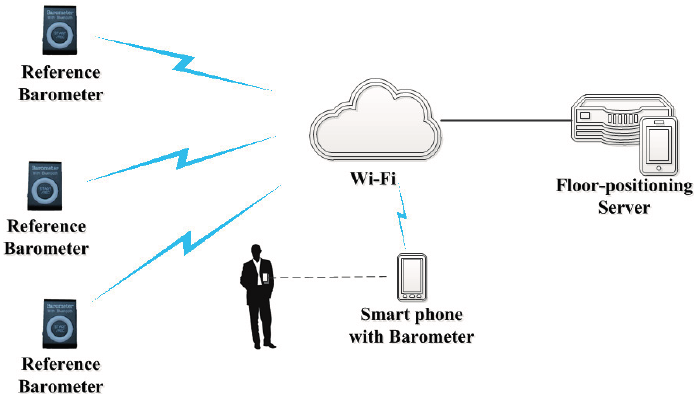
Figure 2. On-line system of floor positioning using multiple reference